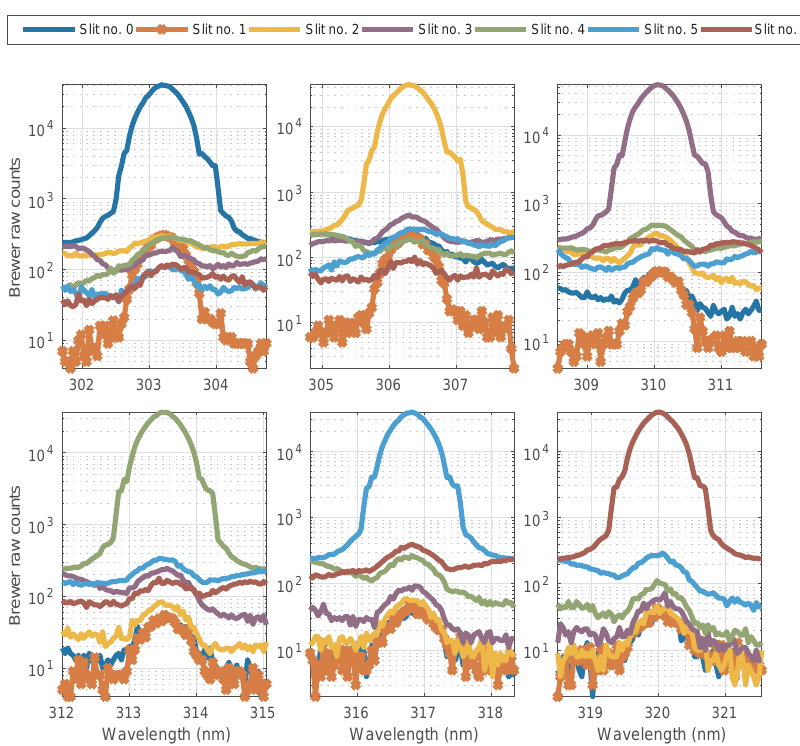
Figure 5. Brewer measurements in the ozone mode while the laser wavelength is changed every 0.04nm. The orange curve corresponds to the dark counts obtained from the measurements of slit